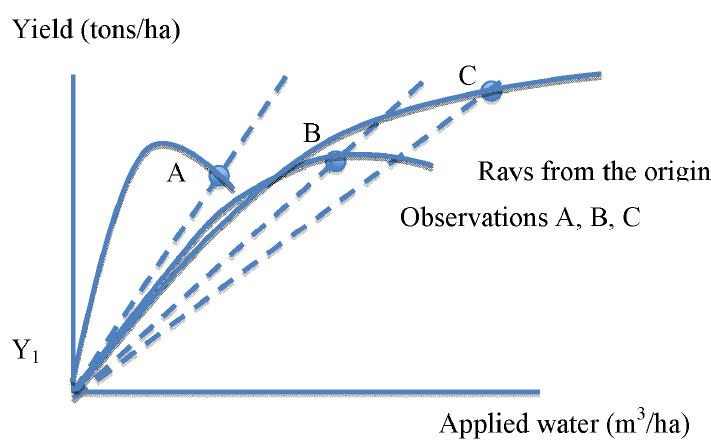
Figure 7. Considering the underlying production